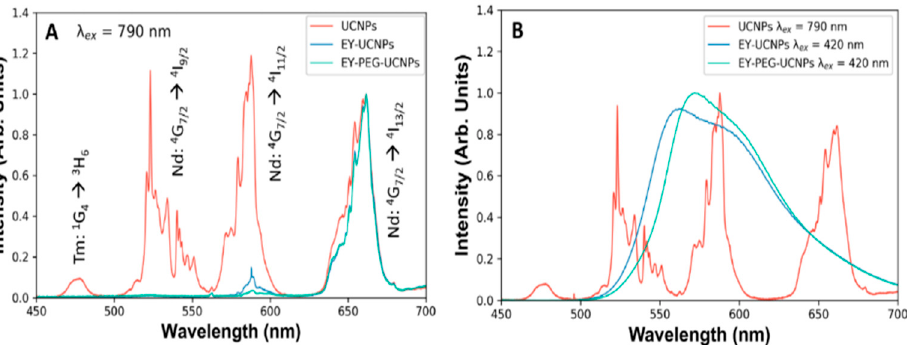
Figure 3. ( A ) Emission spectra of UCNPs, EY-UNCPs, and EY-PEG-UCNPs in the visible region. ( B ) Comparison between the emission bands of UCNPs and the emission bands of EY located in the EY-UCNPs and EY-PEG-UCNPs structures, under direct excitation of